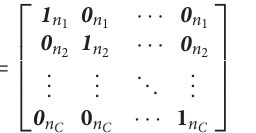
algorithm using two different simulation sources. Three